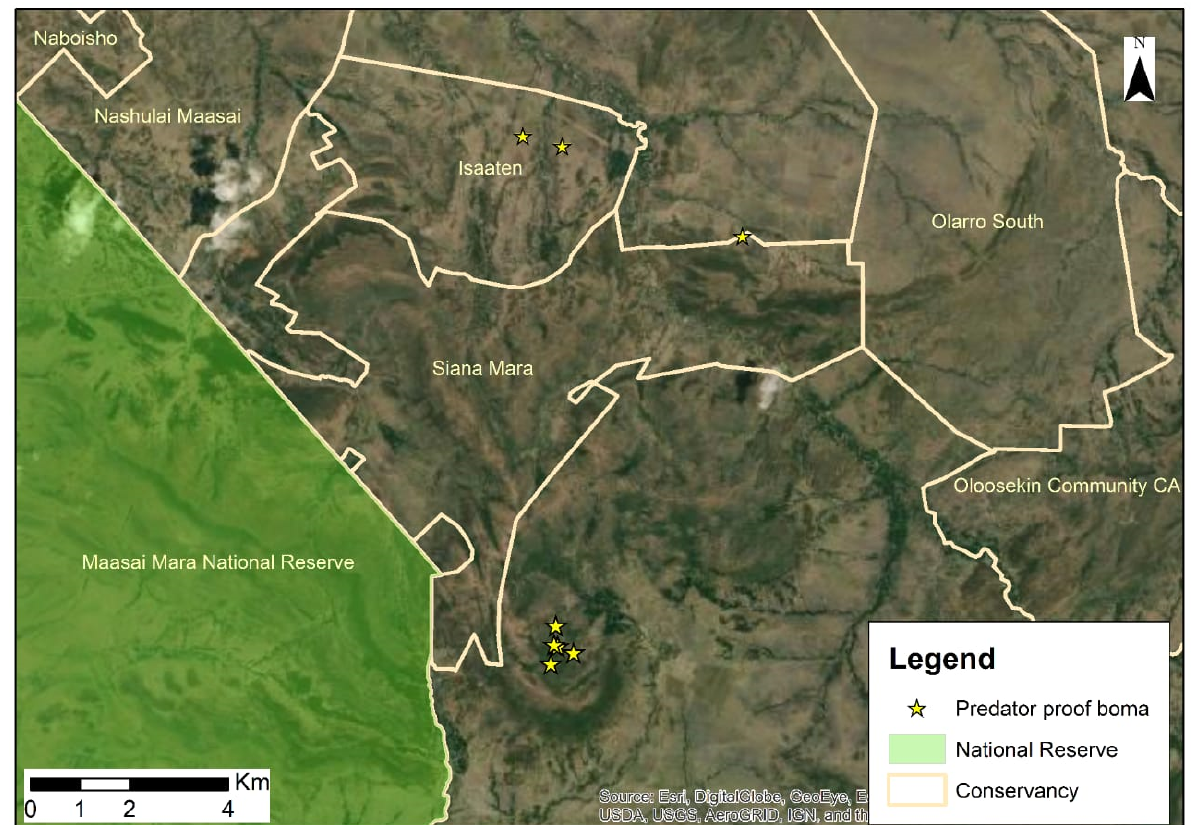
Figure 2. Existing Predator ‐ Proof Bomas.